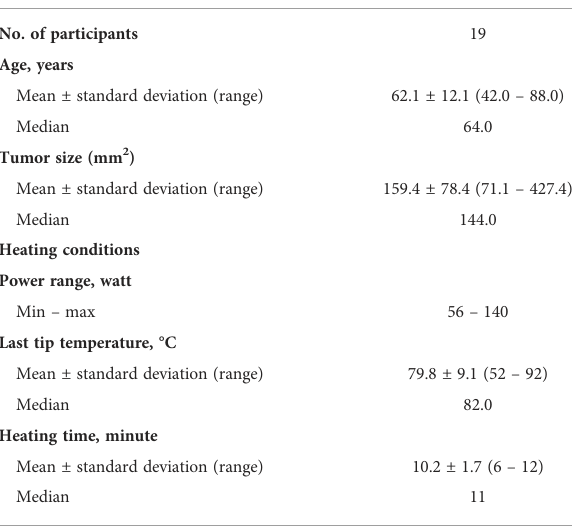
TABLE 1 Demographic data of the patients and RFA parameters used in the